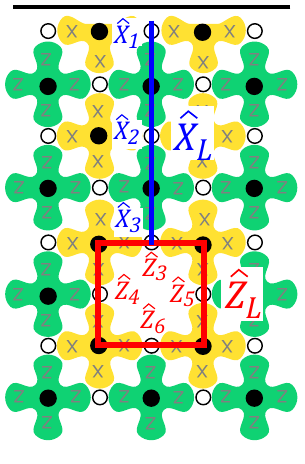
Figure 27: A single Z-cut qubit. The array boundary is indicated by a solid black line (top), while the other three sides of the array continue outwards indefinitely. Two logical operators, = X X X X from the array’s outer X boundary to the internal X boundary of the Z-cut hole, L 1 2 3 = Z Z Z Z and Z surrounding the Z-cut hole, are shown. Note that the operator chains for L 3 4 5 6 X and Z have one physical data qubit in common (data qubit 3). Figure from Ref. (Fowler, L L Mariantoni, Martinis and Cleland,